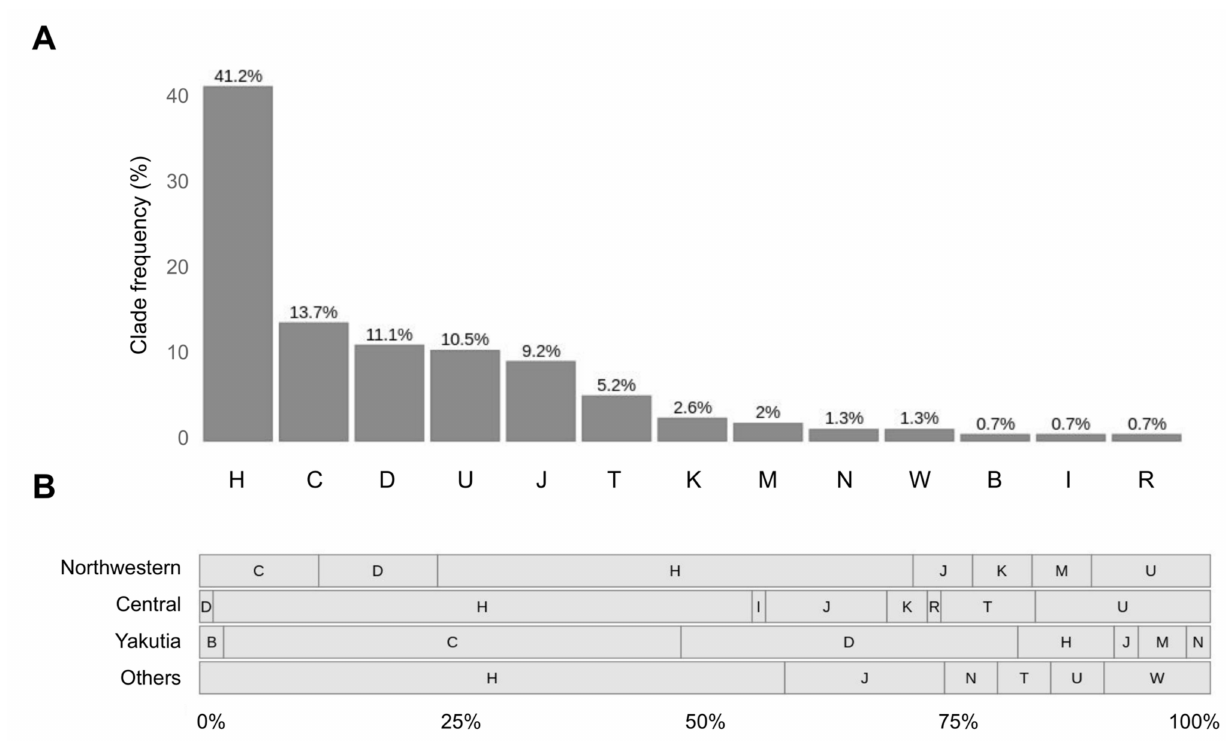
Figure 6. Haplogroup analysis with HaploGrep2. ( A ) Distribution of samples according to their superclade. ( B ) Distribution of samples from different regions according to their superclade. Others include Volga-Ural, Southern, Far Eastern and North Caucasian regions. The bars indicate the proportion of each superclade (percentage from the total number of samples in each